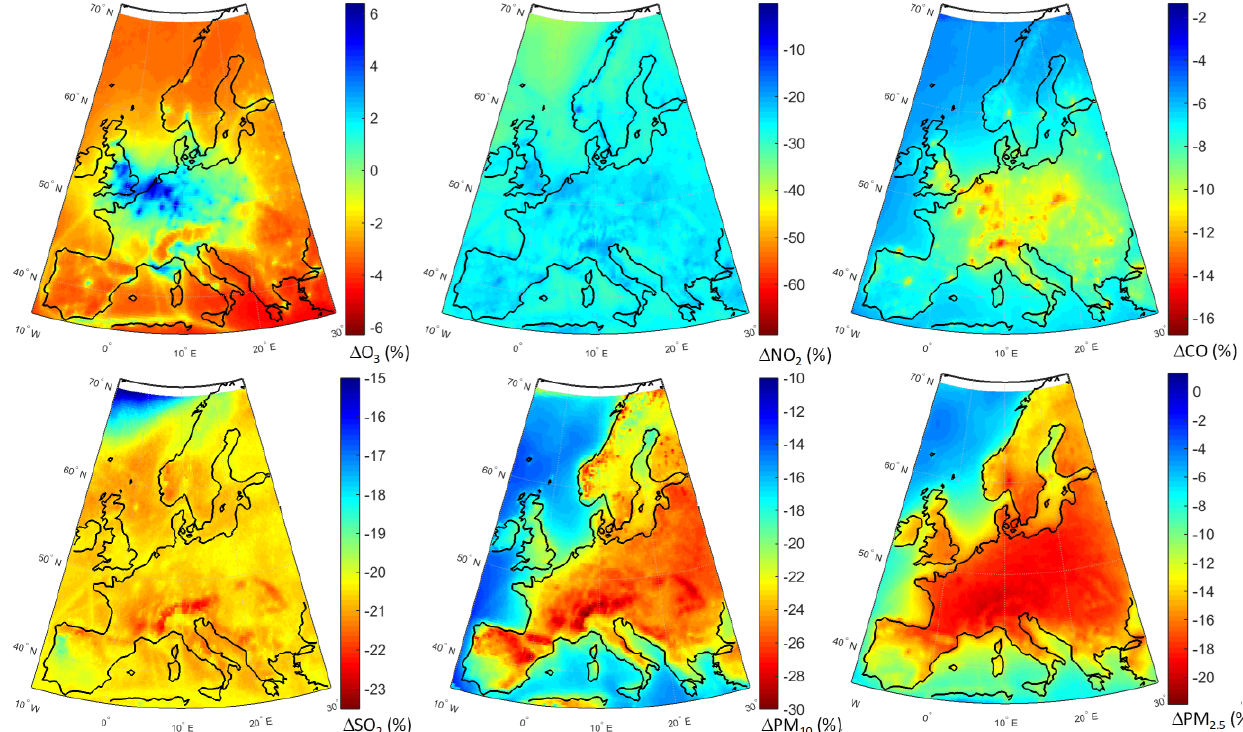
Figure 6. Spatial distribution of the annual mean relative differences between the global perturbation scenario and the base case over Europe as simulated by the multi-model mean